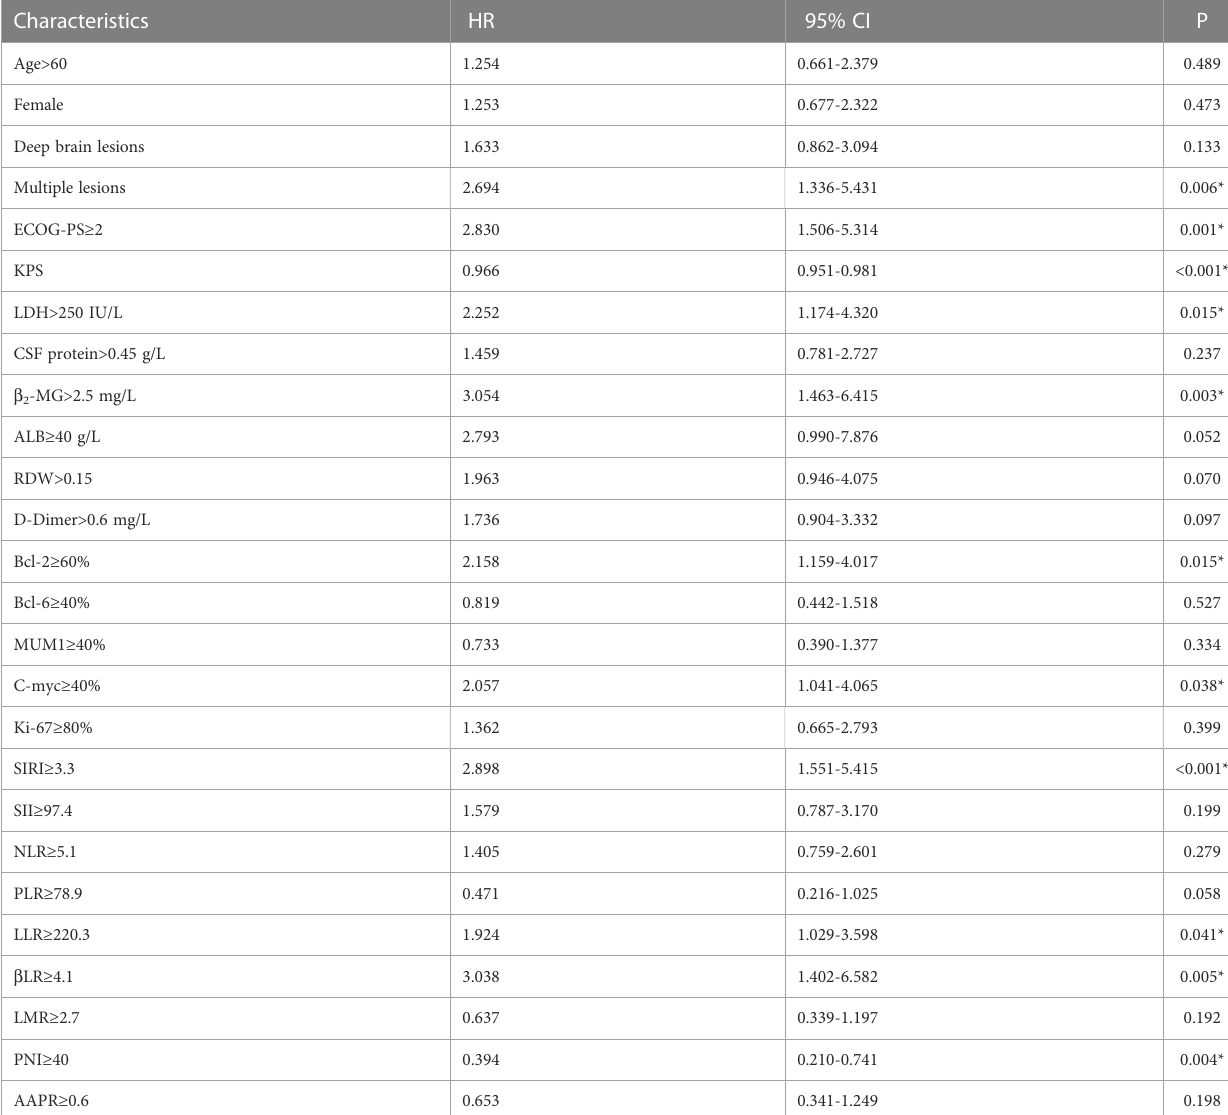
TABLE 2 Univariate Cox regression analysis in the development cohort.